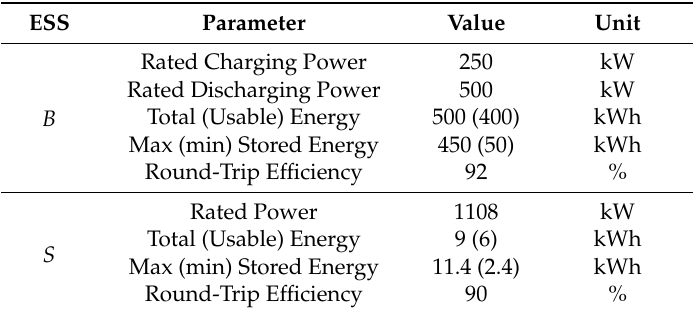
Table 3. HESS parameters and rated values.